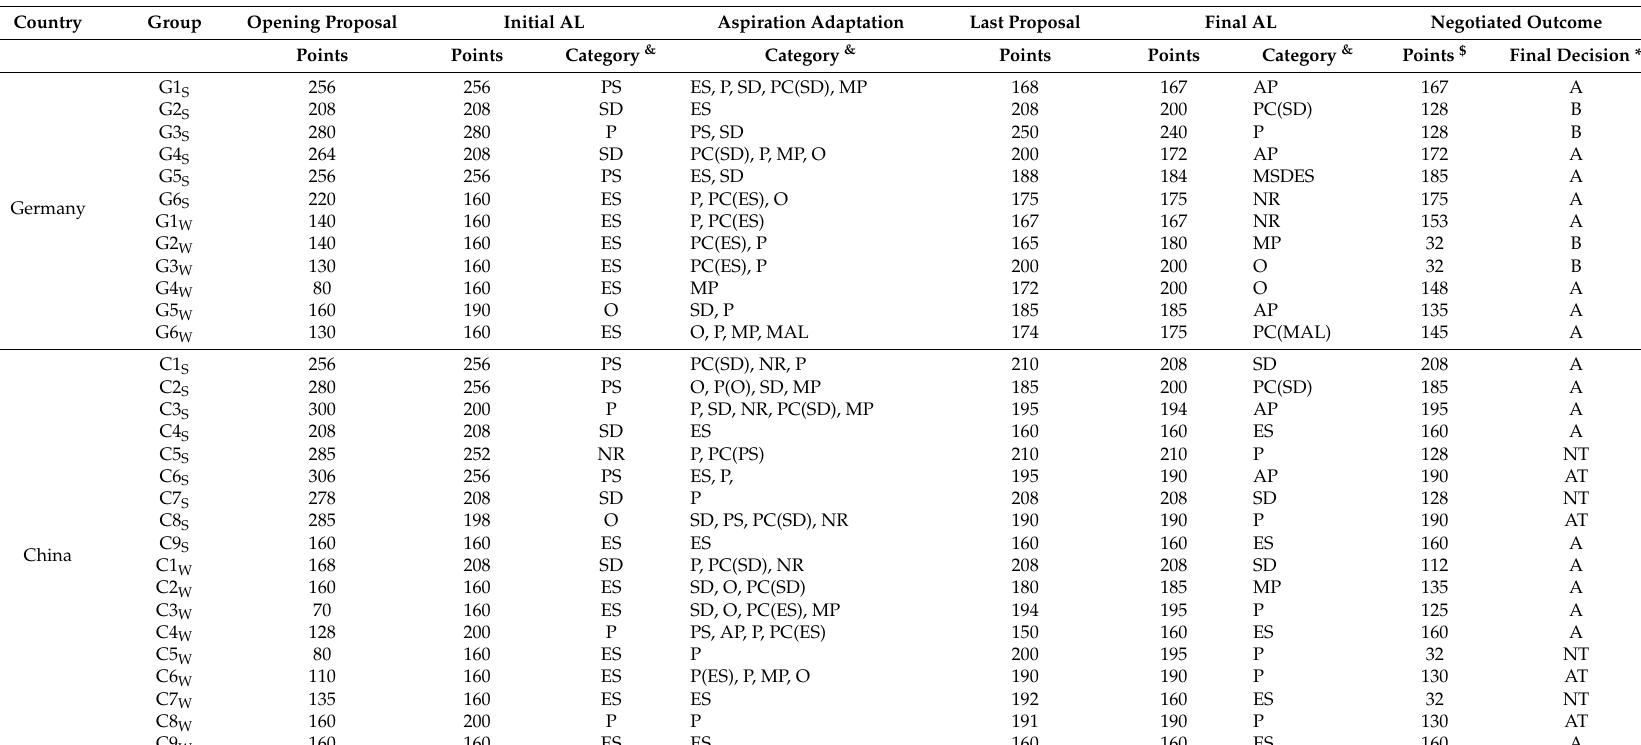
Table 3. Proposals, aspiration levels, and